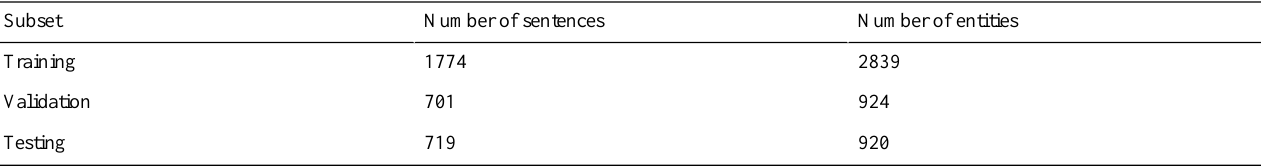
Table 10. IULA Spanish Clinical Record data sets.